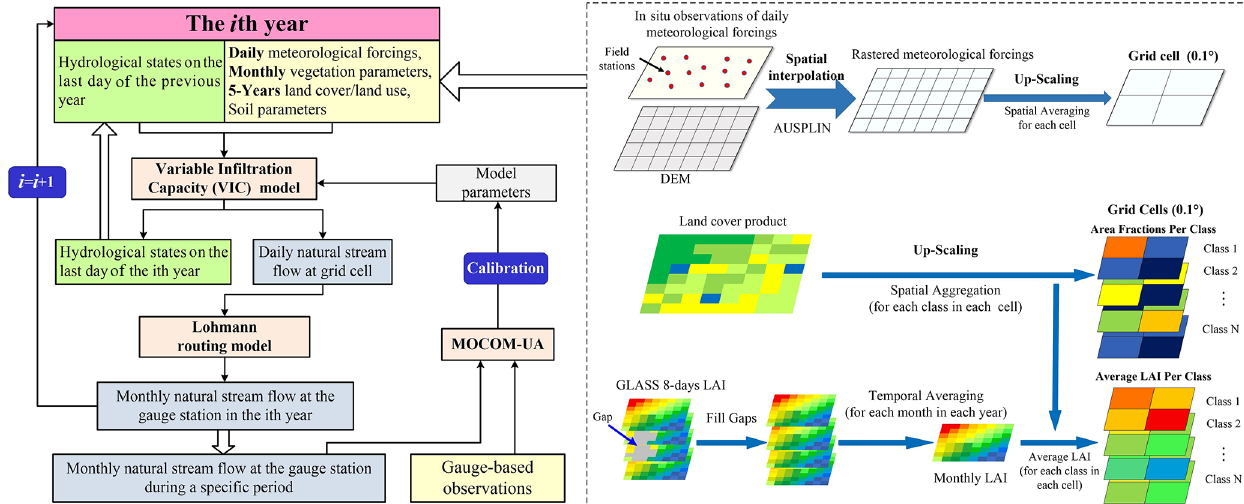
Figure 2. The flowchart of the VIC model setup considering temporally explicit vegetation